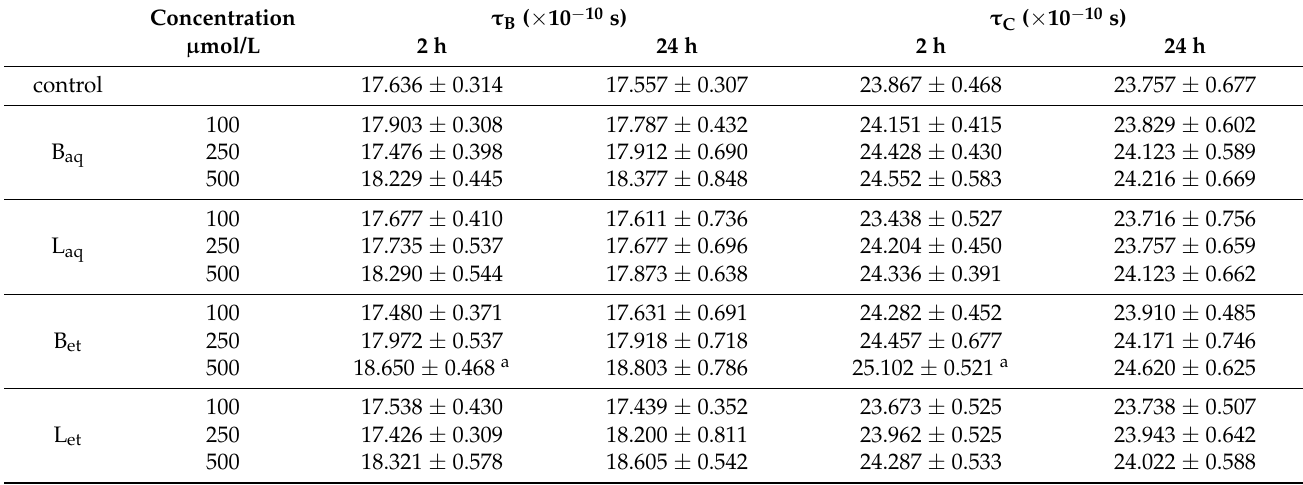
Table 1. Correlation time τ B and τ C for erythrocytes incubated with extracts from U. tomentosa for 2 h and 24 h (B aq –aqueous extract from the bark, L aq –aqueous extract from leaves, B et –ethanolic extract from the bark, L et –ethanolic extract from leaves). Concentration